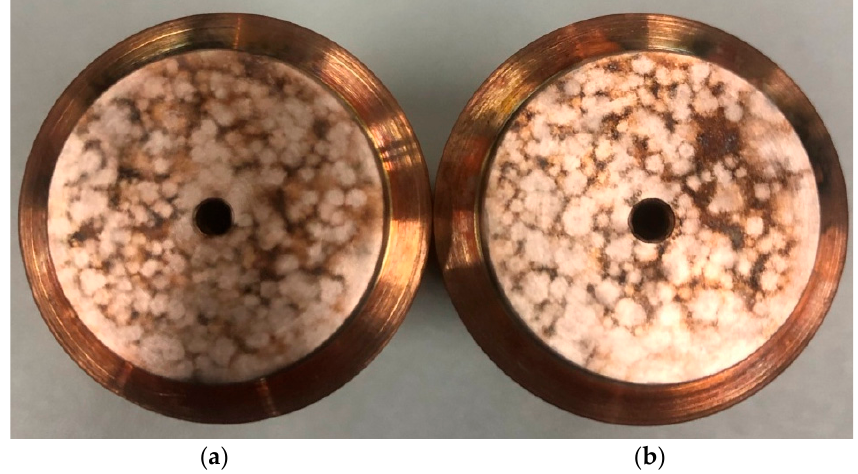
Figure 9. Appearance of contact pads after a series of electrical strength tests: ( a ) grounded electrode, ( b ) high voltage electrode.